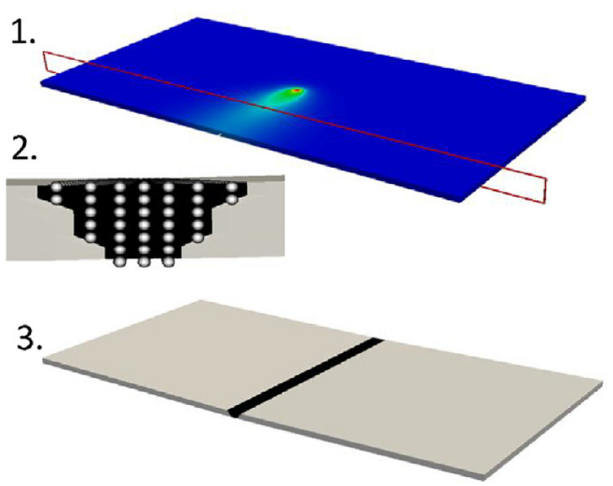
Figure 1. The SCV method uses three main steps to define a melt zone based on the temperature